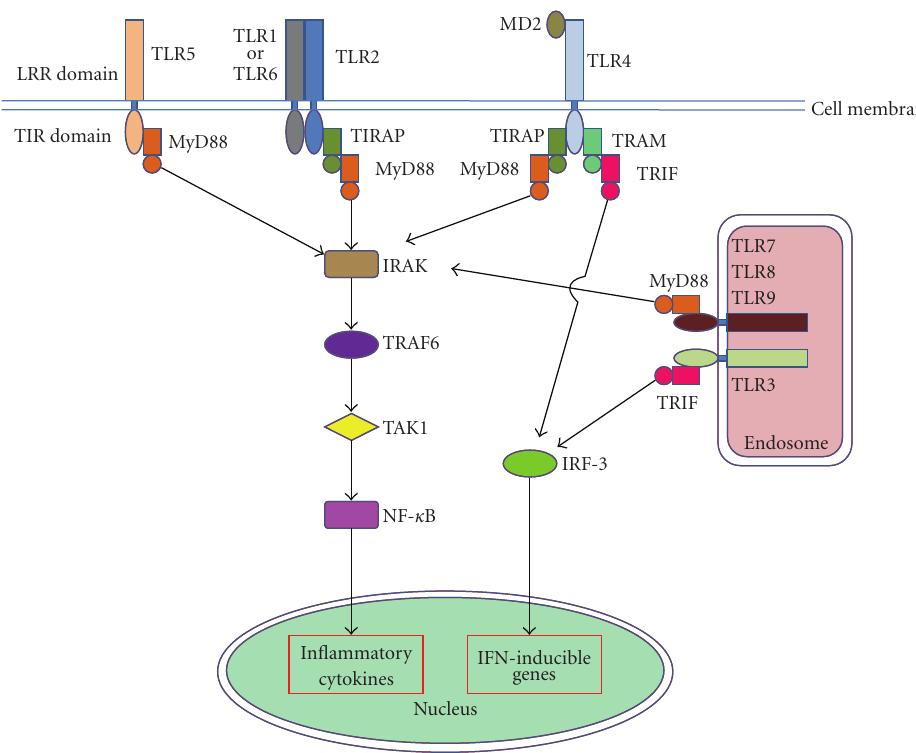
Figure 2: Simplified diagram of TLR signaling